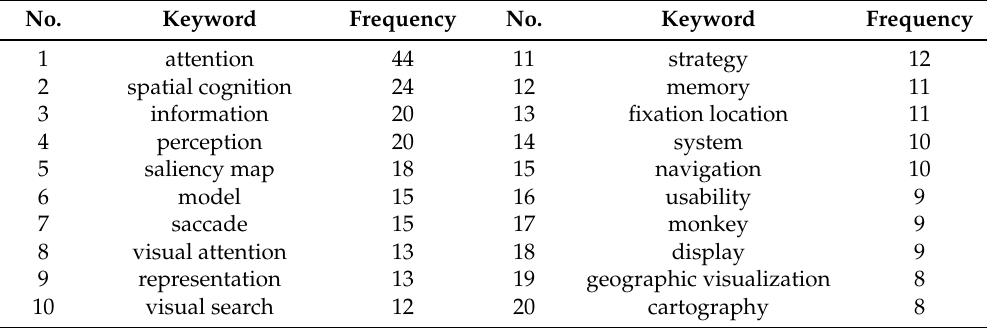
Table 3. Top 20 ranked